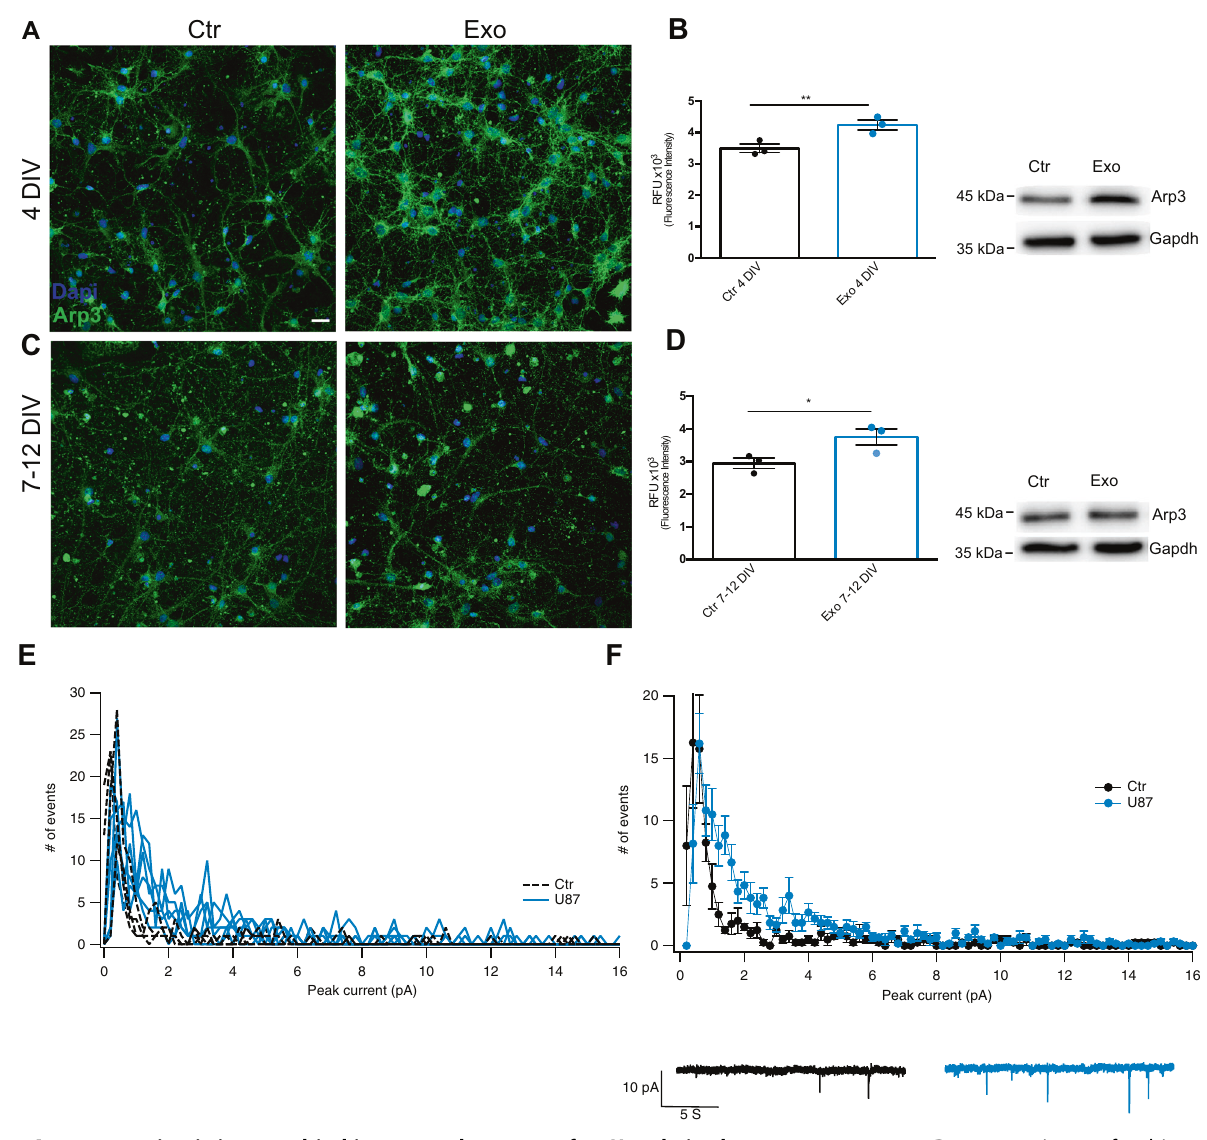
Fig. 4 Arp3 expression is increased in hippocampal neurons after U87-derived exosome treatment. Representative confocal images of control (Ctr) and exosomes treated (Exo) hippocampal neuron cultures at 4 DIV ( A ) and 7-12 DIV ( C ) stained with antibodies for Arp3 (green channel) and DAPI for nuclei (blue channel). Scale bar: 20 µm. Arp3 staining quanti fi cation at 4 DIV ( B ) and 7 – 12 DIV ( D ) showing a statistically signi fi cant increase in both groups. Unpaired Student ’ s t -test, ** p < 0.01, n = 3 independent cell preparations per group; quanti fi cation of 27 fi elds per group from three coverslips, was performed. Graphs show average ± SEM. Representative western blot images from the same experimental conditions are shown on the right; here, GAPDH is used to verify equal loading. E Comparison of synaptic currents at DIV 4. Left : overlay of peak currents distribution from several voltage-clamp recordings. Black: control neurons ( n = 4); blue: U87 exosome-treated neurons ( n = 6). Exosome treatment increased the number of synaptic events between 1 and 6 pA, suggesting higher connectivity. F average peak currents distribution from the recordings shown in ( E ). Kolmogorov – Smirnov test, ** p < 0.01. Representative voltage-clamp traces at − 70 mV in control and U87 exosome-treated hippocampal neurons are shown at the The effect of patient-derived exosomes on neural network in control neurons and in neurons exposed to exosomes. Of activity note, for these experiments, we used LGG patient-derived To bring our fi ndings closer to the clinical setting, we tested the exosomes. The distribution of the amplitudes of detected effect of exosomes derived from three LGG patients (S479, S226, synaptic currents ( n = 23 and 31 neurons for control and and S58, Fig. 6) and two HGG patients (S471 and S496, Fig. 7). exosome-treated groups, respectively) did not show any Given the paucity of the available material from these patients, the statistically signi fi cant difference. However, if we considered number of independent experiments was limited ( n = 1 – 2 for MEA only experiments with low synaptic activity, where glutamater- recordings; n > 8 for intracellular recordings from at least fi ve gic and GABAergic events can be easily distinguished by their different dishes per patient). MEA recordings in DIV 7 – 12 cortical time course (Fig. S7) [40, 41], we found — in two experiments neurons show spontaneous synchronous fi ring (Fig. 6A – C, black with exosomes from a patient — a higher occurrence of traces, upper left panels ). However, following 24 h incubation with glutamatergic events in exosome-treated cultures, in agreement exosomes from LGG patients, spiking synchronicity was disrupted with our histochemical analysis (Fig. 5E, lower panel ).